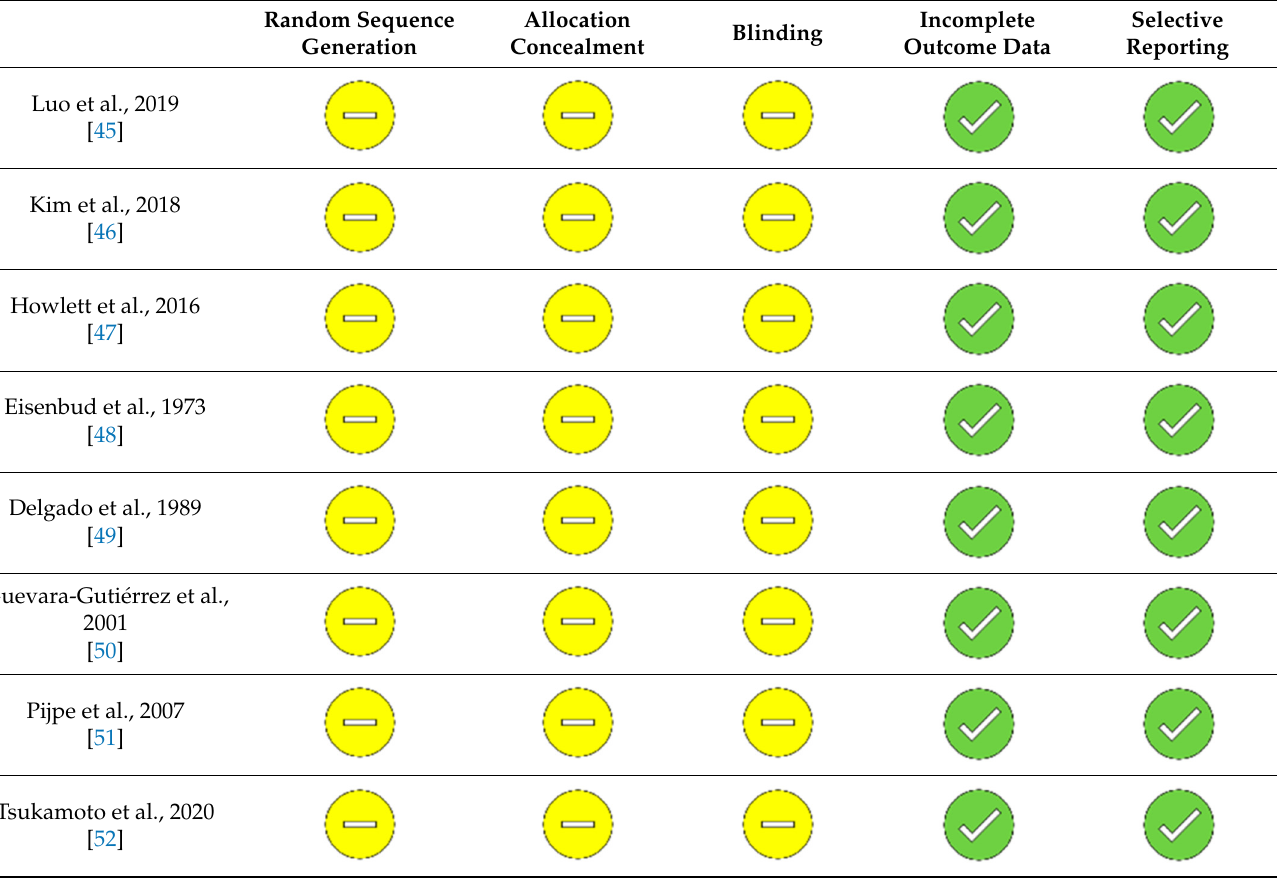
Table 2. Criteria for judging risk of bias in the “Risk of bias” assessment